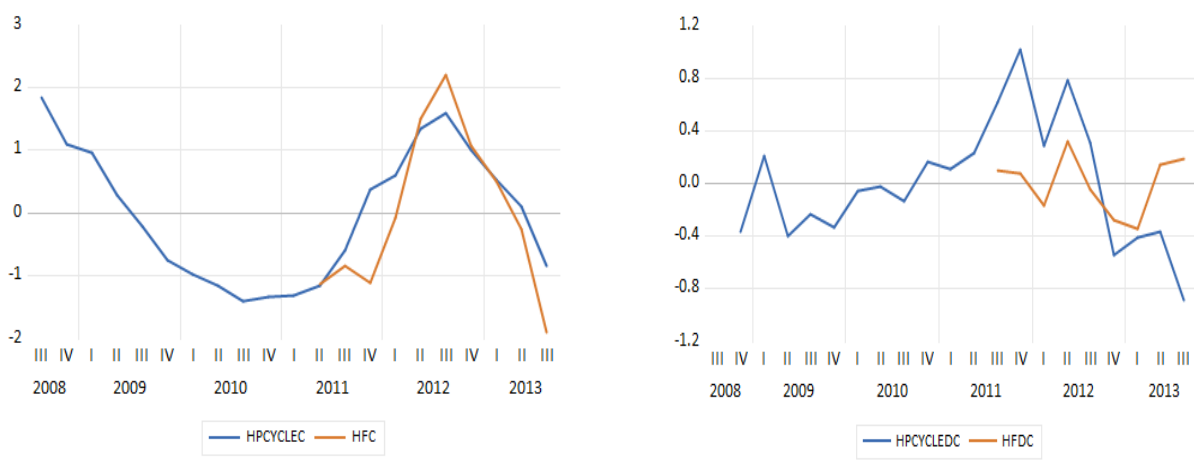
Figure 4. HP (1600) filter (blue) versus 2-year regression filter HF (brown), third period.